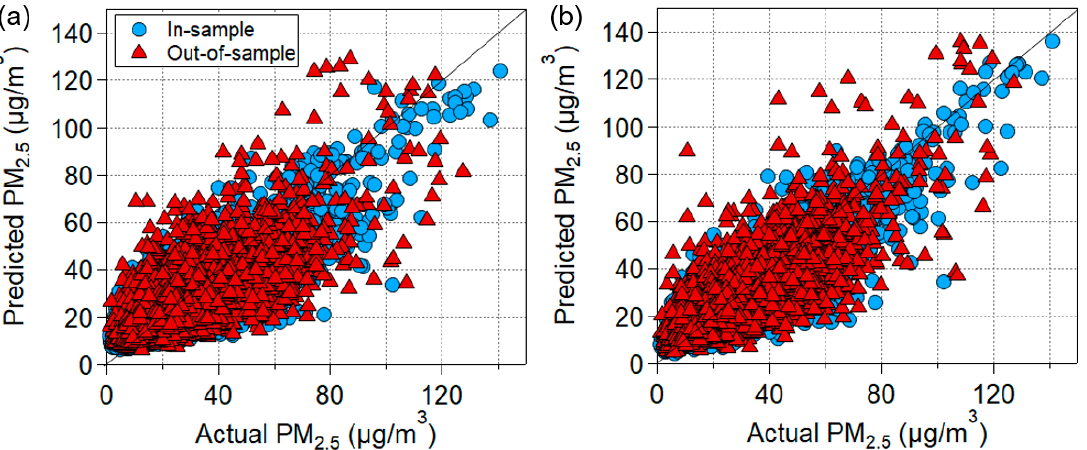
Figure 9. PM 2.5 prediction vs. actual PM 2.5 for the administrative district model: ( a ) not considering accurate weather prediction and ( b ) considering accurate weather prediction. accurate weather prediction and ( b ) considering accurate weather prediction.